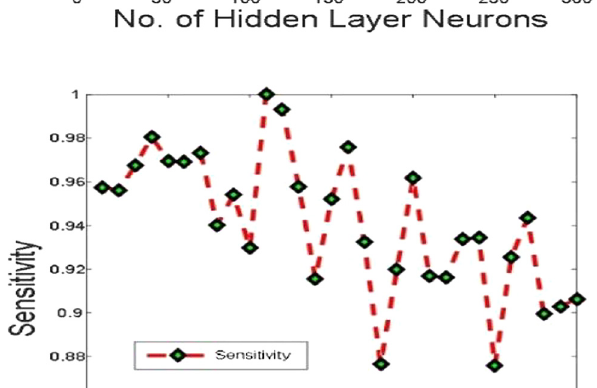
Figure 12: Sensitivity in Jaya-ELM.